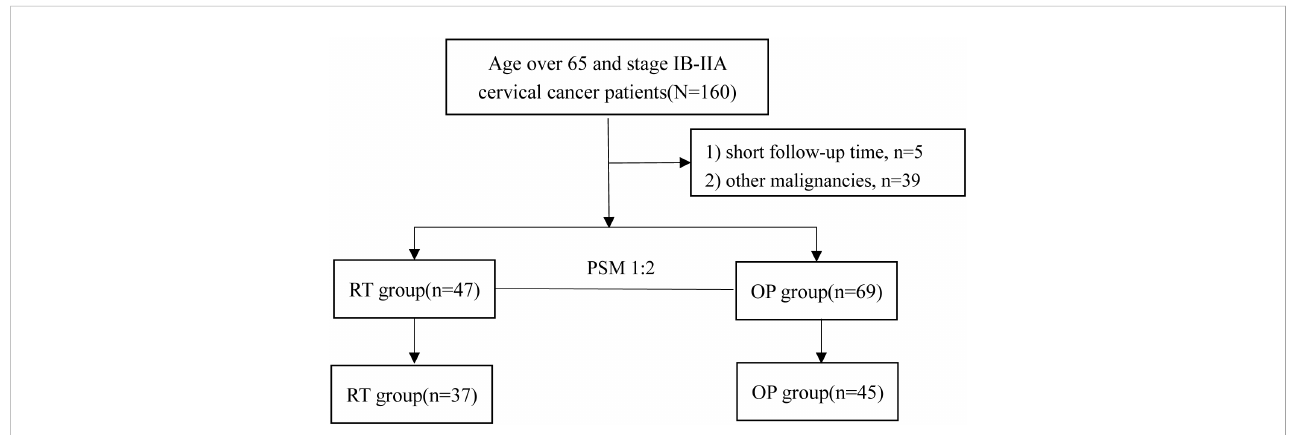
FIGURE 1 Patient inclusion fl ow diagram of the study. PSM, propensity score matching; RT, radiotherapy group; OP, operation